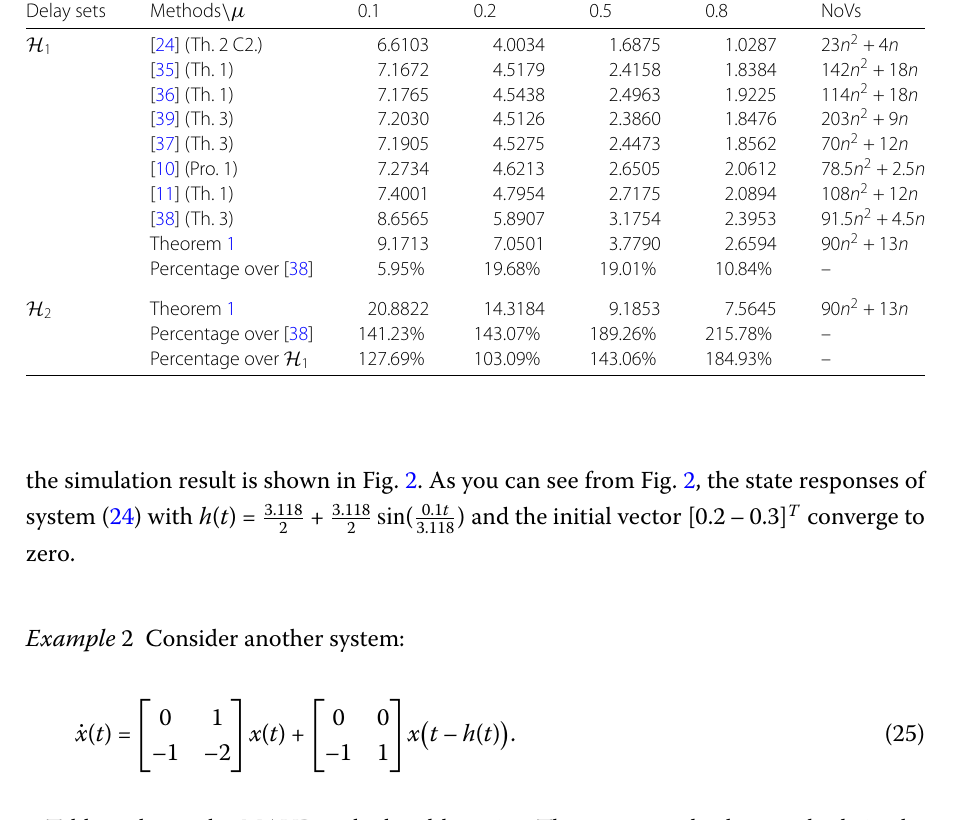
Table 2 MAUB s under different μ for Example 2 Delay